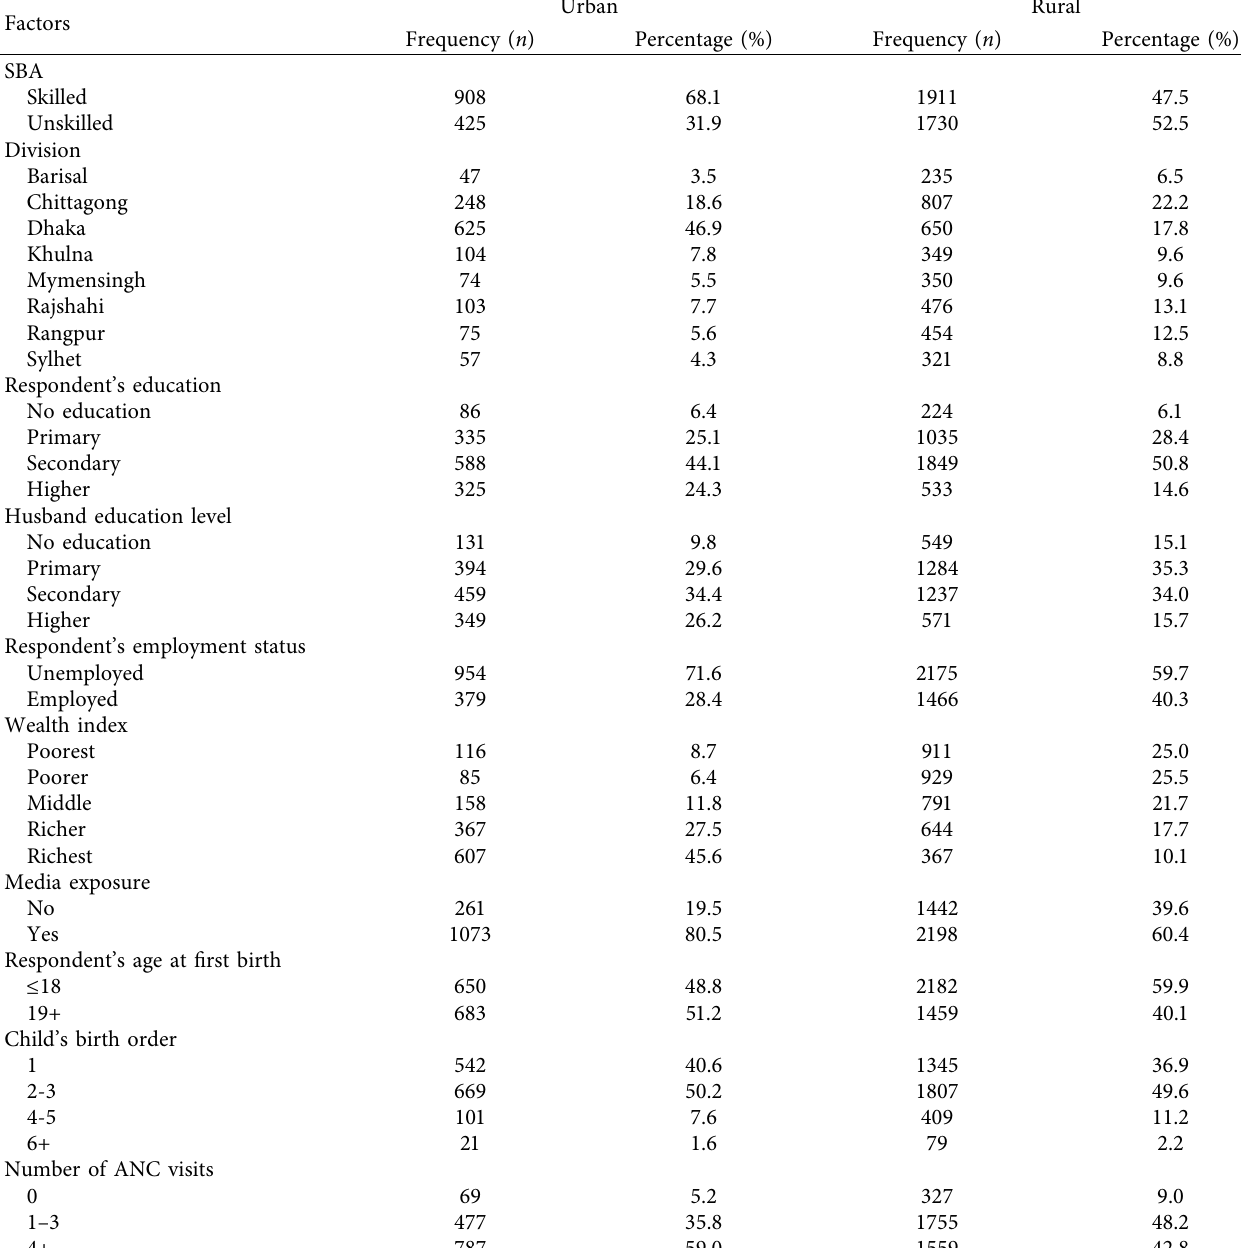
Table 4: Frequency distribution in terms of urban and rural women for selected